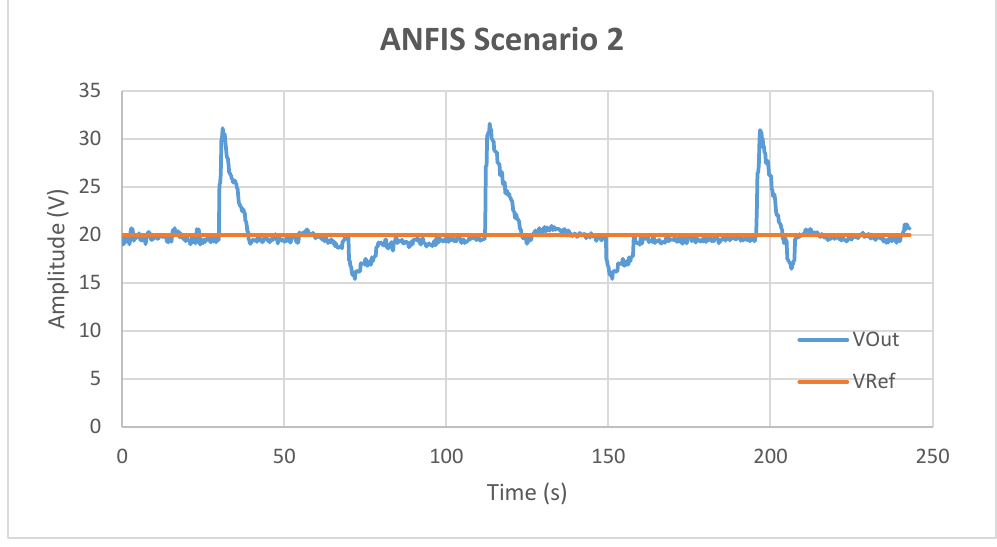
Figure 25. The response results of load changes with ANFIS controller.